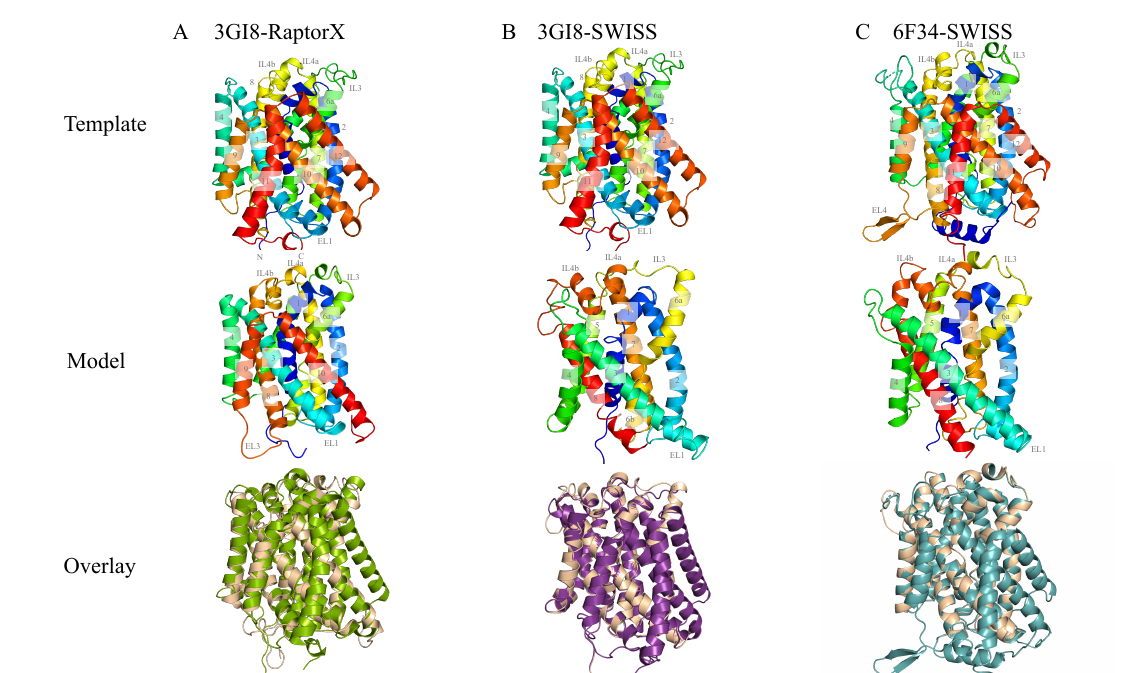
Figure A2. In this figure the templates 3GI8 [25] ( A , B ) and 6F34 [26] ( C ) are compared with the created GerAB models. The structures are colored according to the topology defined in Figure 2. The colors in the overlay of A are green for the template 3GI8 and cream for the 3GI8-RaptorX model. The colors in the overlay of B are purple for the template 3GI8 and cream for the 3GI8-SWISS model. In C the template 6F34 is depicted in blue and the 6F34-SWISS model again in